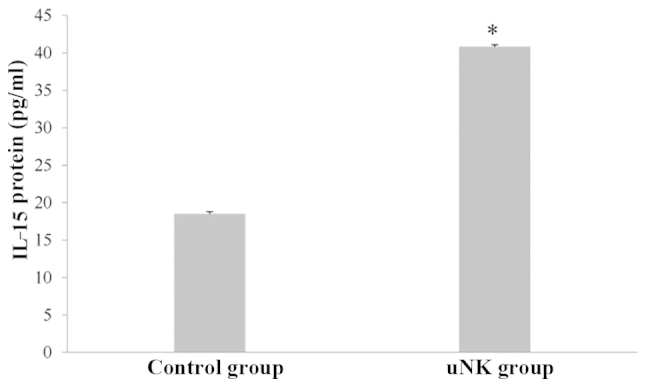
IL-15 levels in control and uNK groups. An enzyme-linked immunosorbent assay was used to measure IL-15 levels in supernatants from co-culture systems treated for 6 h with conditioned medium from decidual uNK cells or with control medium. Data are presented as the mean ±standard error of the mean. Values were corrected for the quantity of IL-15 detected in the control and uNK cell-secretion medium prior to addition to the co-culture systems. *P<0.01, compared with the control group. IL-15, interleukin 15; uNK, uterine natural killer cells.